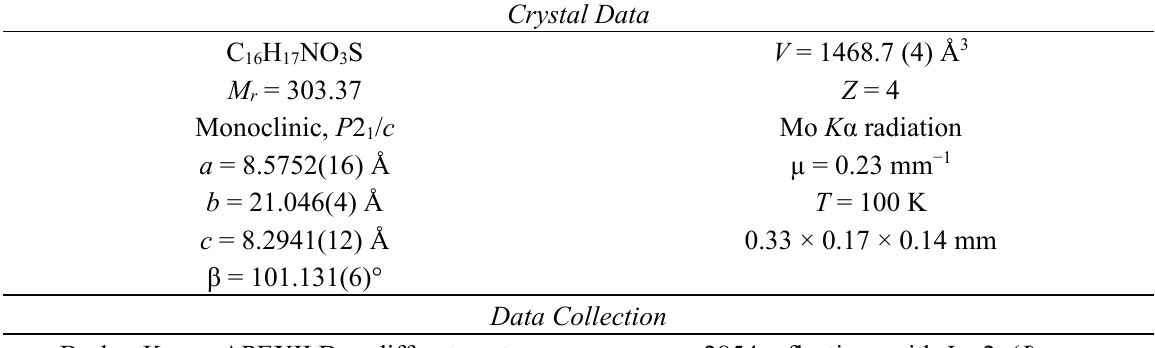
Table 1. The crystal and experimental data of compound 2 .